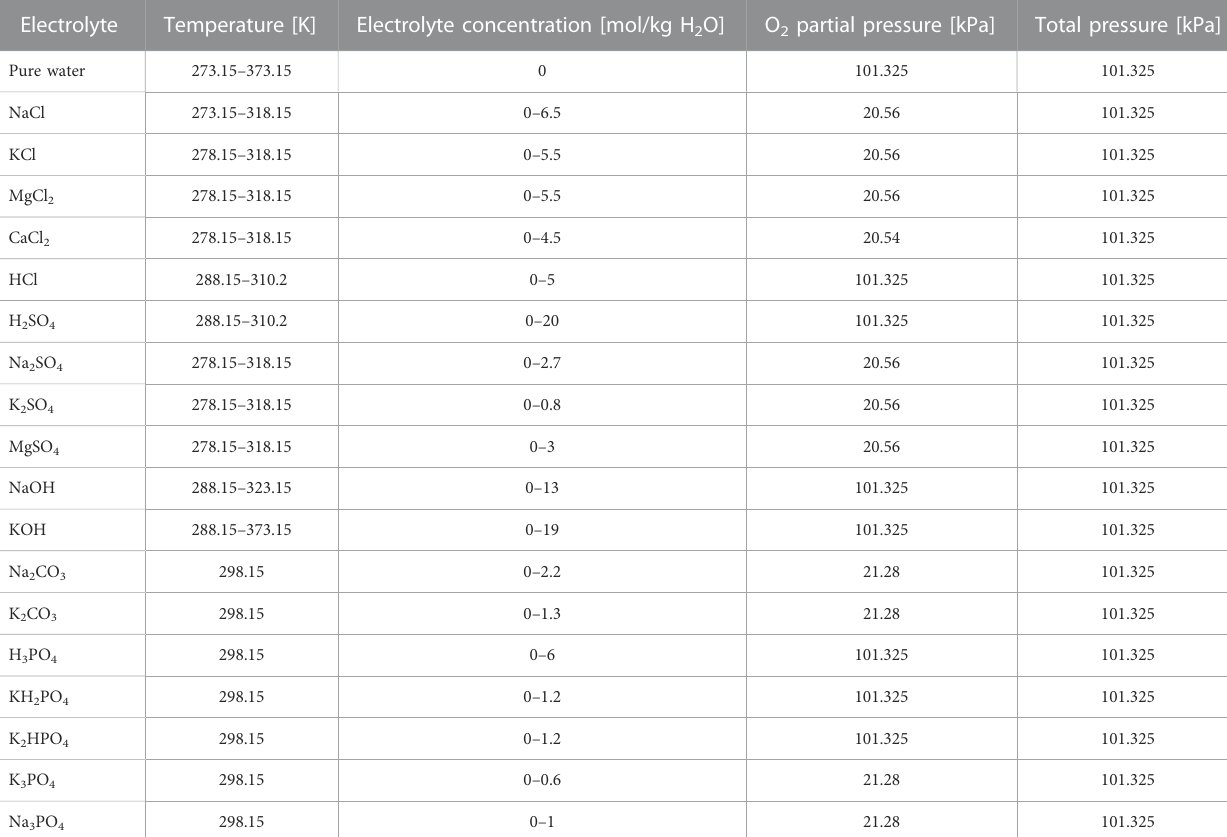
TABLE 10 Validity ranges (T, I, p) according to the experimental conditions used for the parameter fi tting.